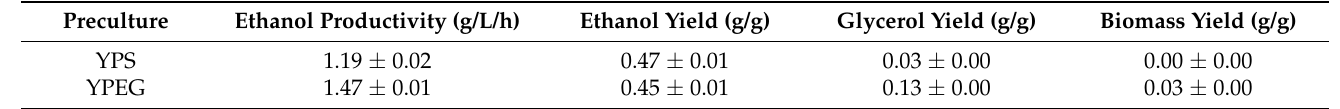
Table 2. Product yields of fermentations performed with YPS and YPEG cells on softwood hydrolysate in a 0.67 L controlled bioreactor. Averages and standard deviations of two individual experiments are presented.